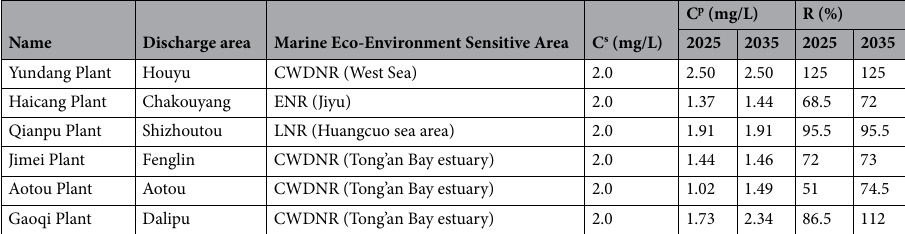
Table 7. Ecological impact index (R) of each outfall on marine eco-environment sensitive area.